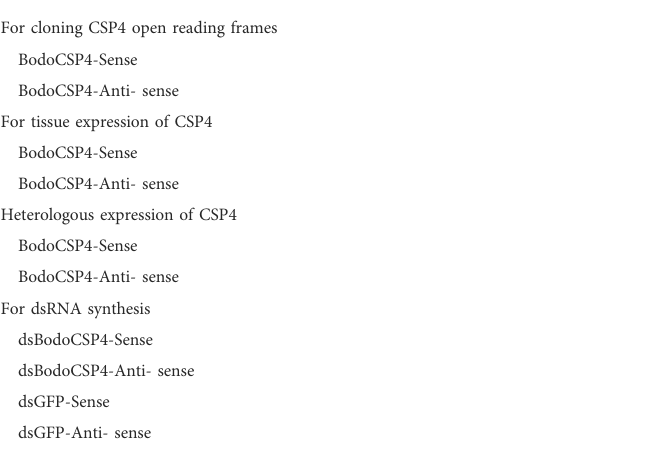
vector (TransGen, China) and sequenced.